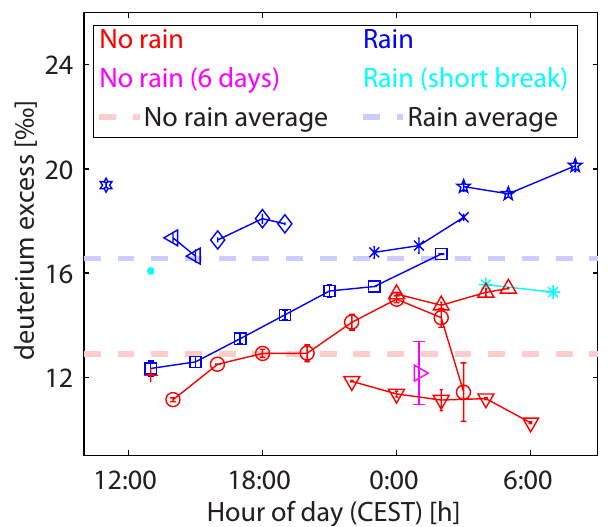
Fig. 4. Temporal evolution of the deuterium excess ( d = δ 2 H c − 8 × δ 18 O c ) including measurement errors for the cloud events during HCCT-2010. Different symbols are used for the different events (see Table 1). Different colors are linked to precipitation at Schm¨ucke. Red symbols are used if there was no rain since the last cloud event and pinc indicates that there was no rain within the last 6 days. The mean value of those values is indicated as a red dashed line. Blue is used for cloud events where precipitation did not stop one hour before the cloud event and cyan is used for cloud events when precipitation stopped within one day before the cloud event. The mean value of those cloud events is indicated as a blue dashed